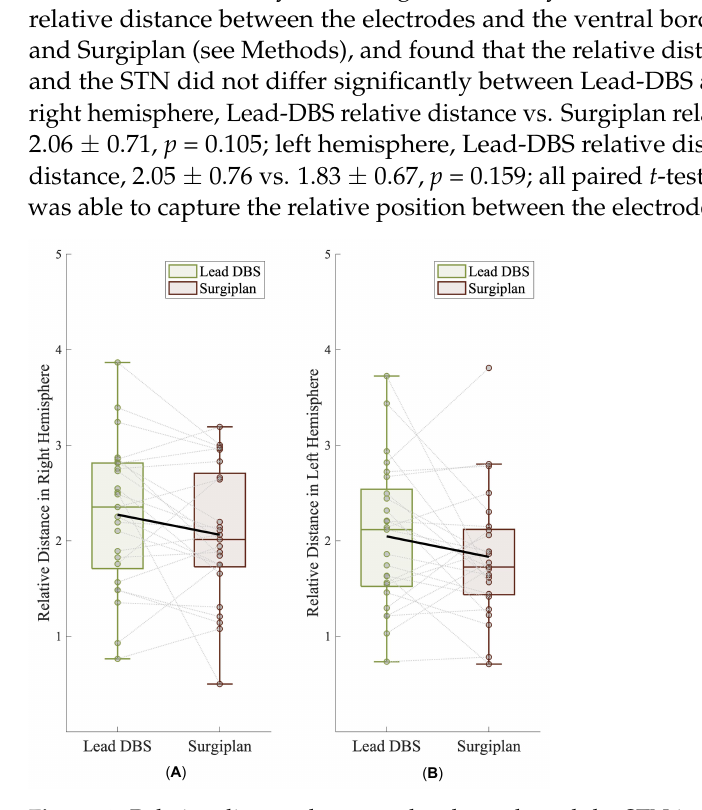
Figure 4. Relative distance between the electrode and the STN in Lead-DBS and Surgiplan. The relative distance between the electrode and the STN in Lead-DBS and Surgiplan did not differ significantly in right ( A ) or left ( B ) hemispheres (right hemisphere, paired t -test, Lead-DBS relative distance vs. Surgiplan relative distance, 2.27 ± 0.75 vs. 2.06 ± 0.71, p = 0.105; left hemisphere, paired t -test, Lead-DBS relative distance vs. Surgiplan relative distance, 2.05 ± 0.76 vs. 1.83 ± 0.67, p =